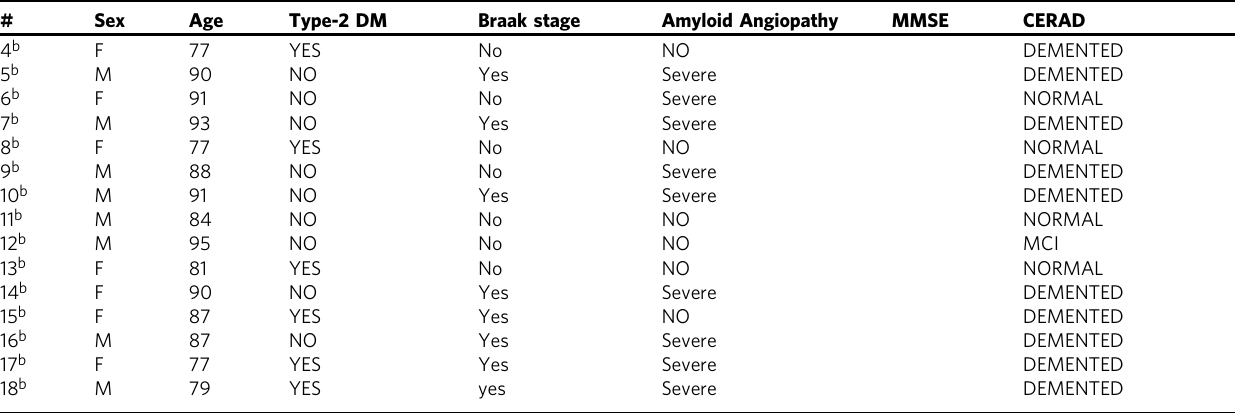
Table 3 Summary of histopathological analysis of cerebrovascular amylin-A β deposition in sAD and fAD brains. Cerebrovascular amylin, A β and amylin-A β deposits (sAD) Independent amylin deposits in vasculature